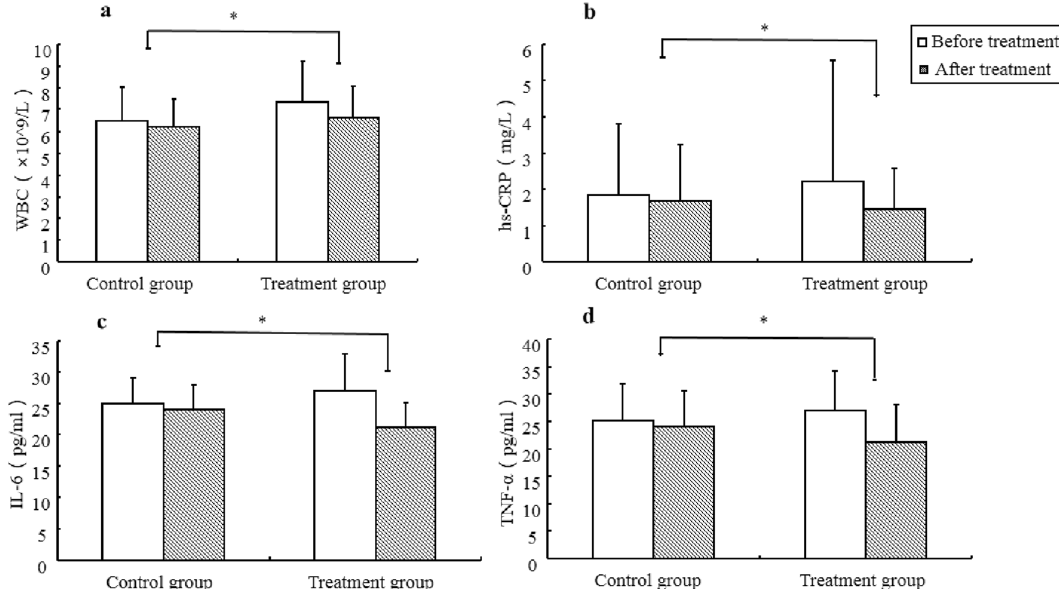
Figure 4. The treatment group presented a more robust decrease in inflammatory indicators white blood count ( a ) and high-sensitivity C-reactive protein ( b ) and the inflammatory factors Interleukin 6 ( c ) and Tumor necrosis facter-α ( d ) than the control group. * p < 0.05; WBC white blood cell, hs-CRP high-sensitivity C-reactive protein, IL-6 interleukin 6, TNF-α tumor necrosis